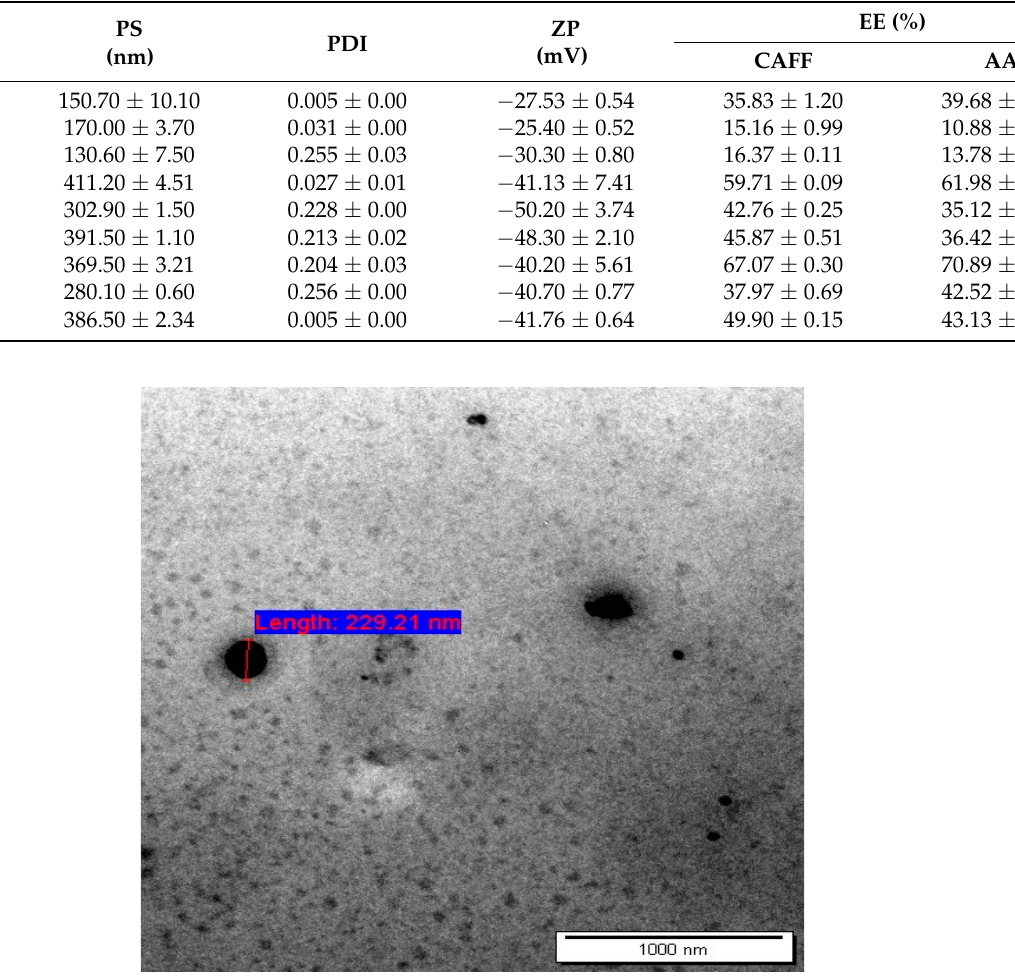
Figure 3. Transmission electron microscopy (TEM) micrographs of AA and CAFF-loaded niosome at a magni fi cation of 50 kx.